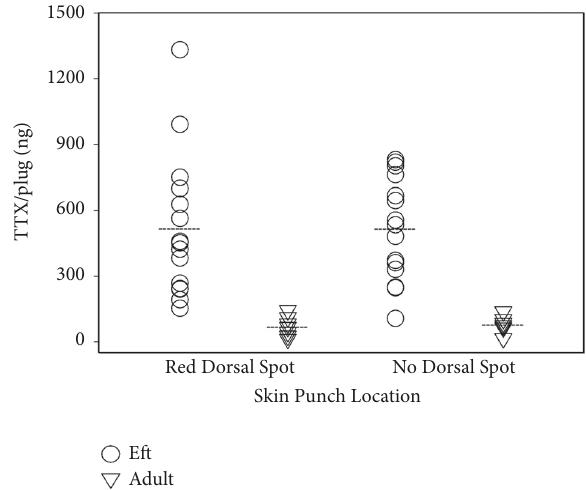
Figure 1: Concentration of tetrodotoxin (TTX) per plug (ng) in brightly spotted and unspotted dorsal epidermis samples from Eastern newt ( Notophthalmus viridescens ) efts (circles) and adults (triangles). A paired t-test found no significant difference between the mean concentrations of TTX in pigmented samples ( t = 0.014; df = 14; P = 0.989) from efts or adults ( t = -0.453; df = 6; P = 0.667). Means are represented by dashed lines. Adult newts have significantly lower concentrations of TTX in their skin than efts ( t = 4.6, df = 20, P <